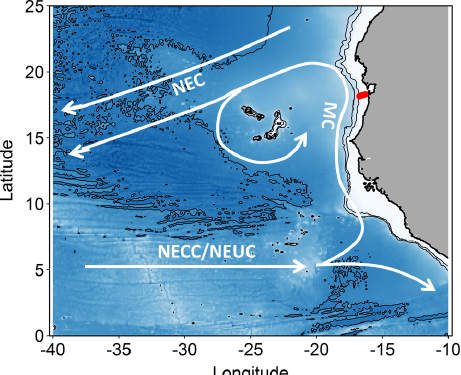
Figure 1. Map of the study area. Stations along the transect dur- ing cruise M107 (June 2014) are displayed in red and major cur- rents with white lines (adapted from Brandt et al., 2015). MC rep- resents Mauritania Current; NEC represents North Equatorial Cur- rent; NECC represents North Equatorial Countercurrent; NEUC represents North Equatorial